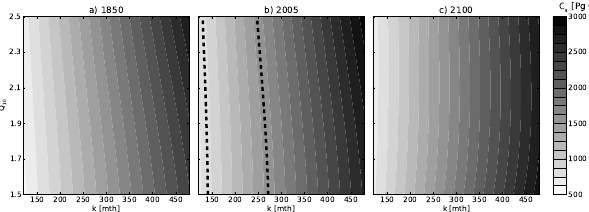
Figure 1. Snapshots of total soil carbon in the reduced complexity model as a function of parameter values. Dashed contours in panel (b) indicate the CI 95 of the Harmonized World Soil Database in 2005